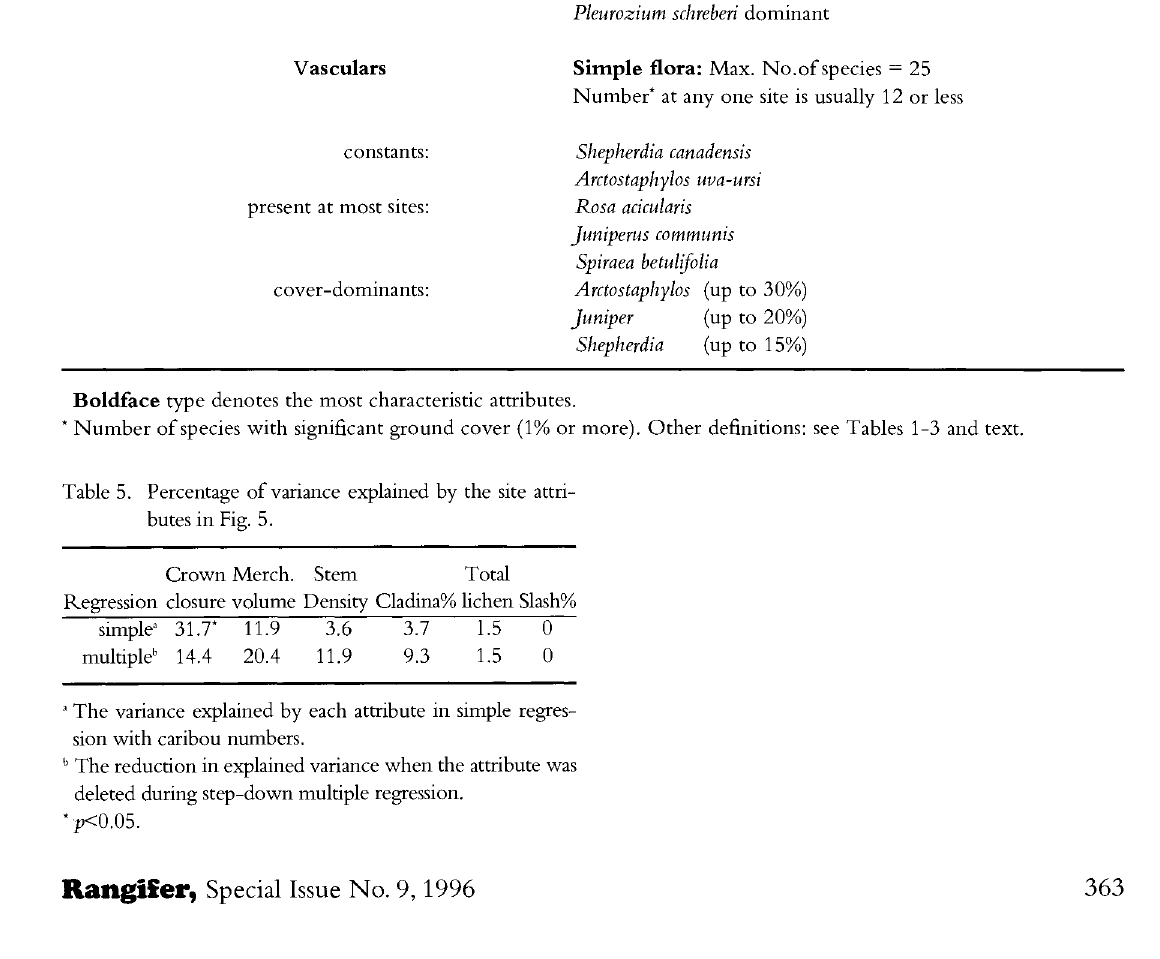
Table 5. Percentage of variance explained by the site attri butes in Fig.